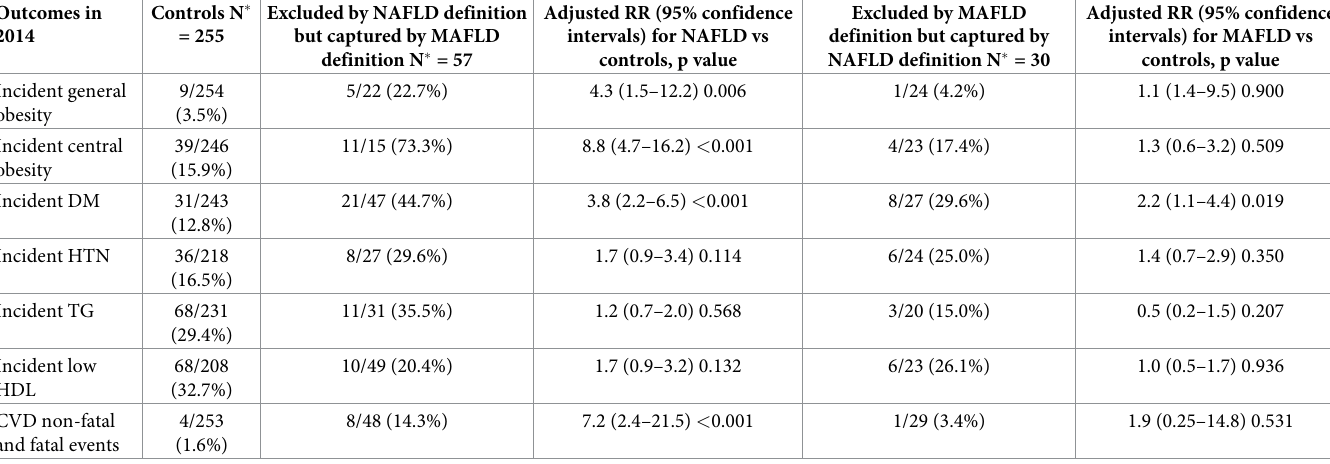
Table 4. New-onset metabolic features and cardiovascular events (with n, % and age-sex adjusted risk ratios) after 7-years (2014) among controls and those excluded by NAFLD and MAFLD